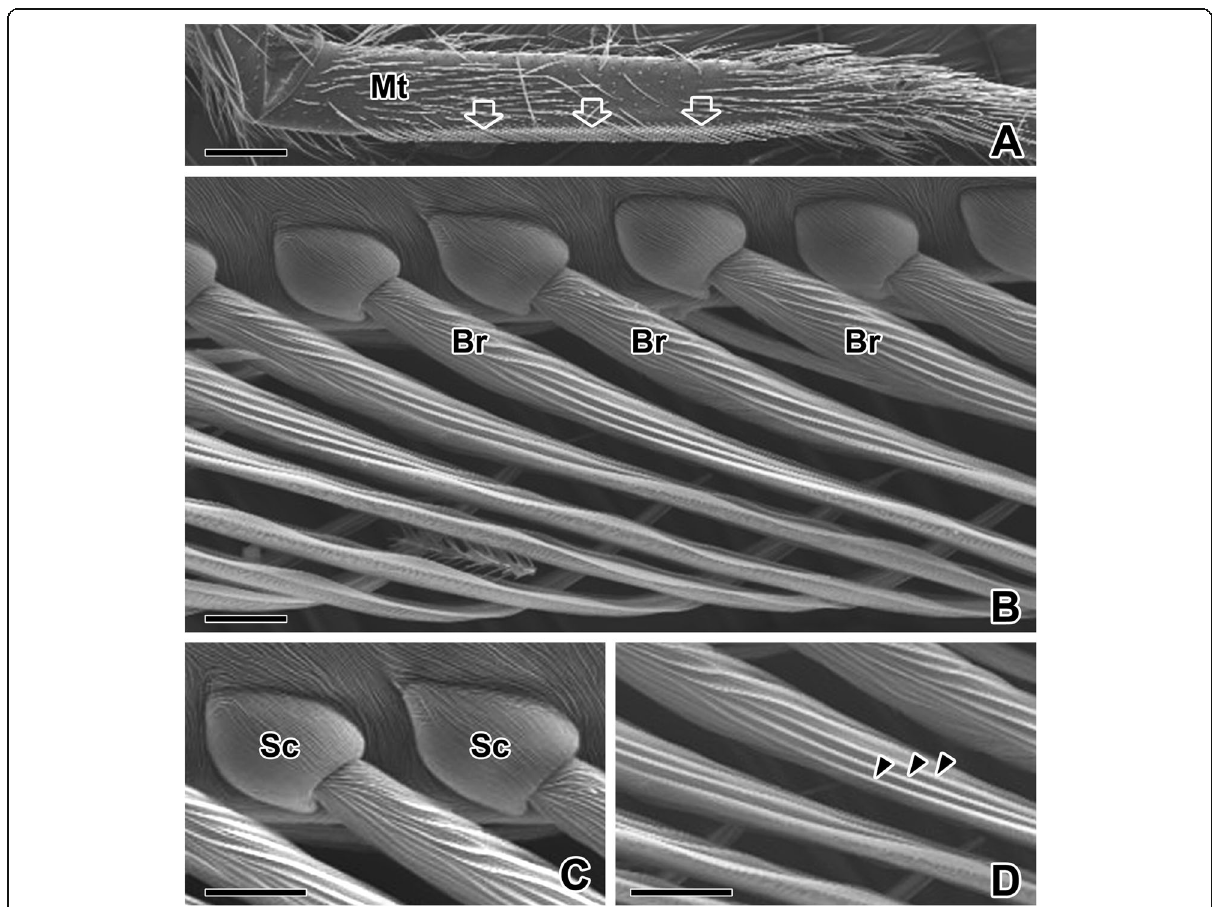
Fig. 3 Scanning electron micrographs of the calamistrum combs in the spider N. albofasciata . a On the upper margin of the metatarsus (Mt) segment of the 4th leg, a specialized comb of bristles, called a calamistrum (arrows) is located. b The bristles (Br) are long, straight, and have a pointed end toward the tip. c Each bristle of the calamistrum is embedded in a cuticular socket (Sc). d The surface of the bristle is completely covered with longitudinal grooves (arrowheads). Scale bars indicate 200 μ m ( a ) and 10 μ m ( b-d